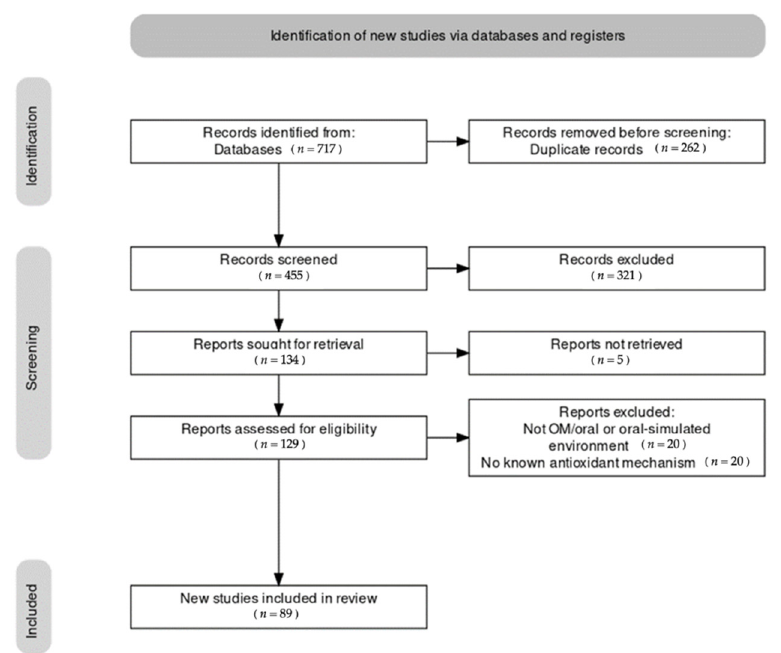
Figure 1. Results of the literature search. Note that during the identification stage, an indeterminate number of non-English articles were excluded prior to screening via automatic tool.